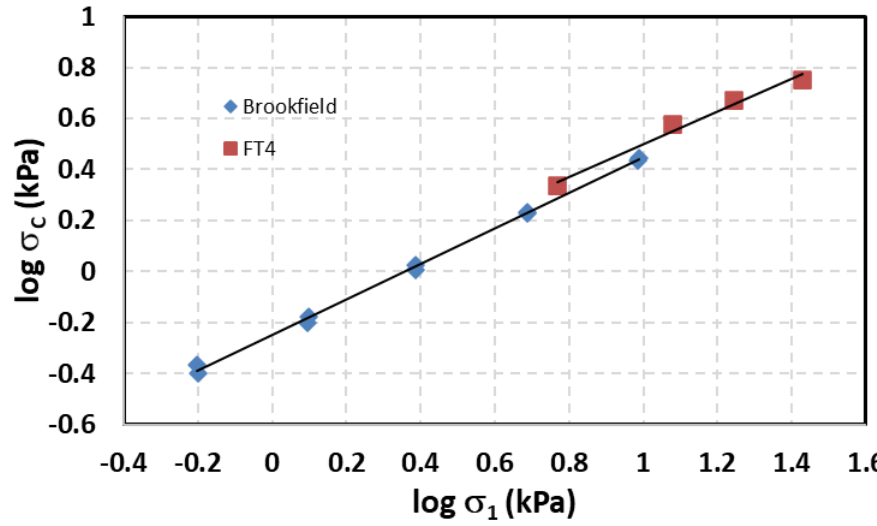
Figure 10. Flow function of lactose.